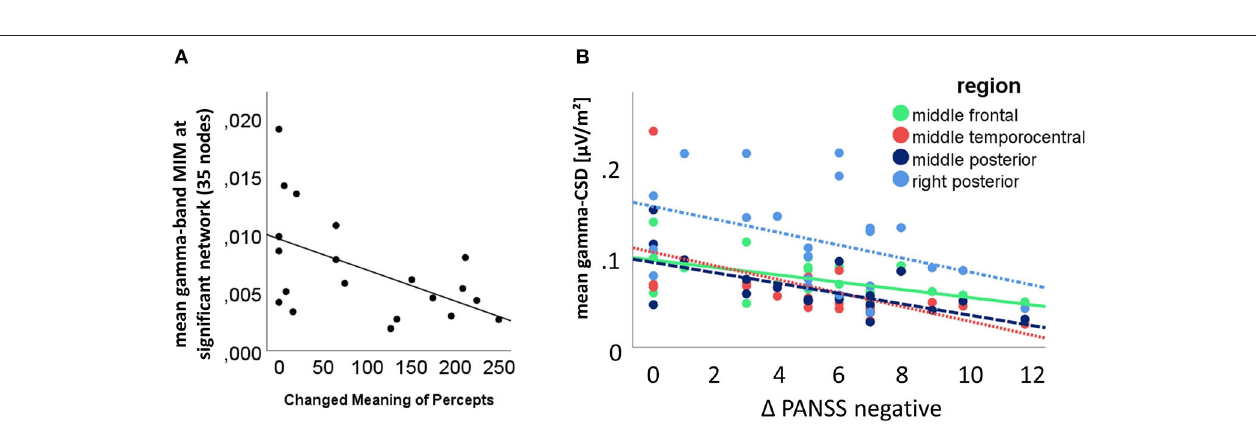
FIGURE 6 | Mean (A) gamma- and (B) theta-band connectivity across the nodes of the significant networks for the ketamine and placebo condition, *** p < 0.001 (Bonferroni-corrected).